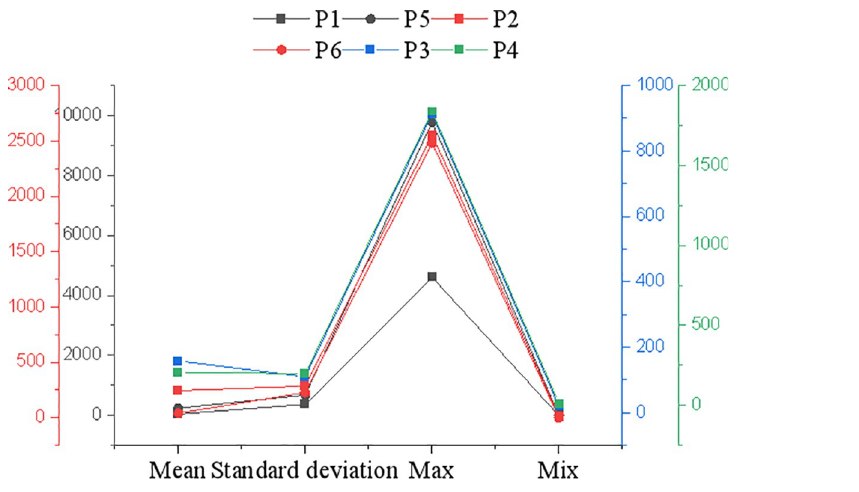
Fig 3. Descriptive statistics of each variable.